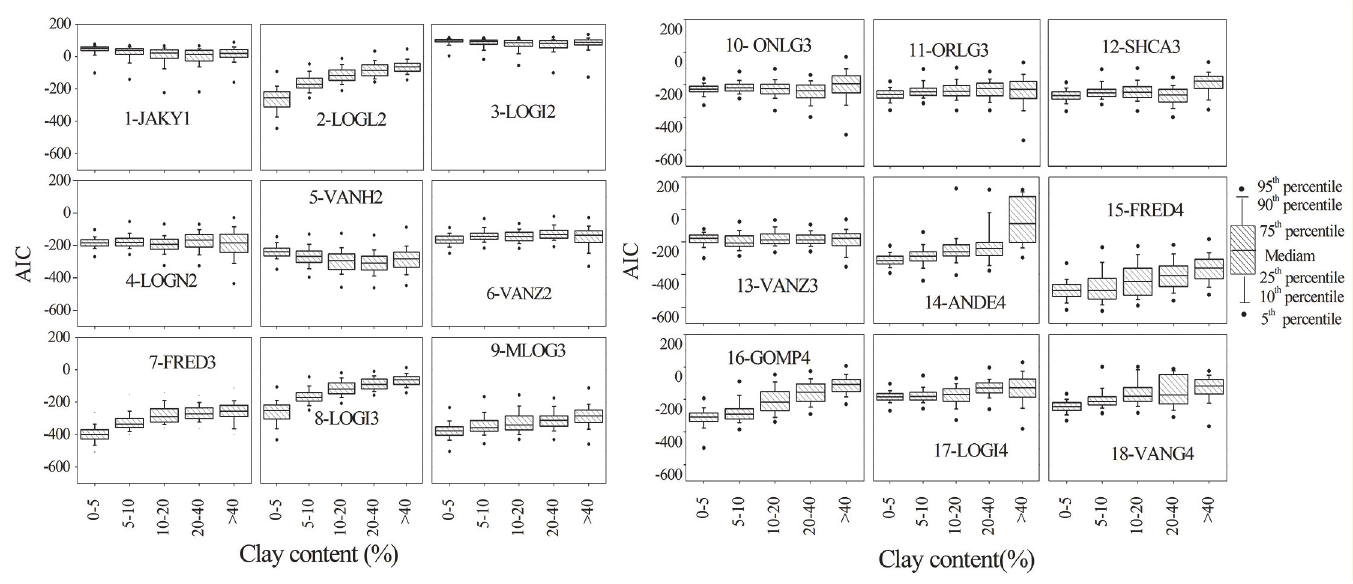
Fig 5. Box plots showing model performance with varying clay content of soils.